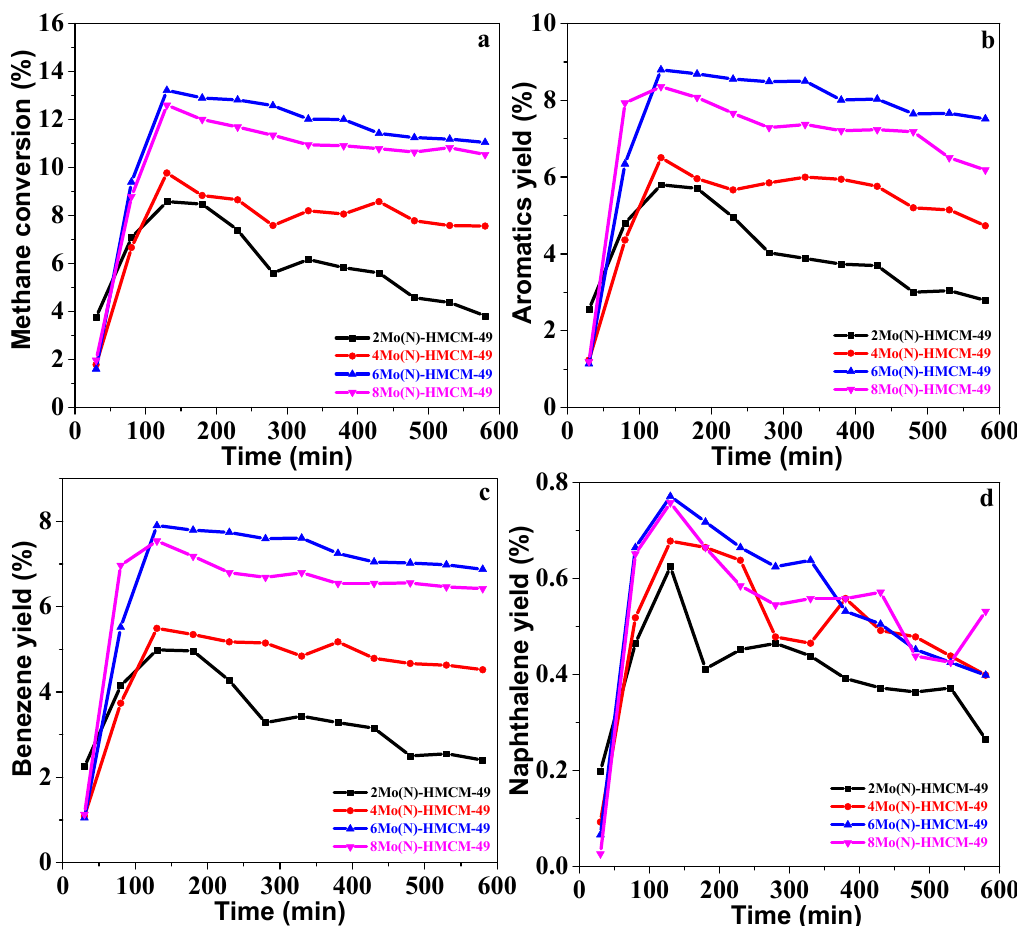
Figure 1. ( a ) Methane conversion, ( b ) Aromatics yield, ( c ) Benzene yield, and ( d ) Naphthalene yield over 2Mo(N)-HMCM-49 ( ■ ), 4Mo(N)-HMCM-49 ( ● ), 6Mo(N)-HMCM-49 ( ▲ ), and 8Mo(N)-MCM-49 ( ▼ ). Reaction conditions: T (temperature) = 700 °C, P (pressure) = 1 atm, GHSV(gas firing hourly space velocity) = 1500 h − 1 .